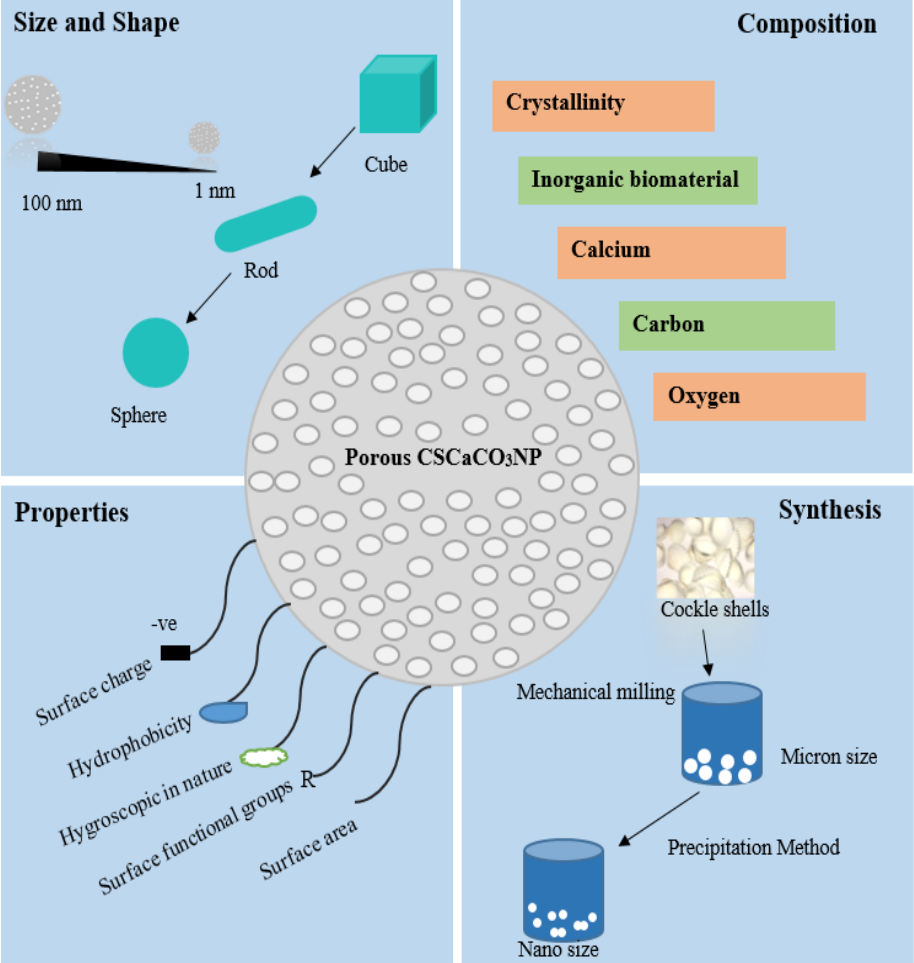
Figure 2. Properties and synthesis of veteran cockle shell-derived calcium carbonate nanoparticles.